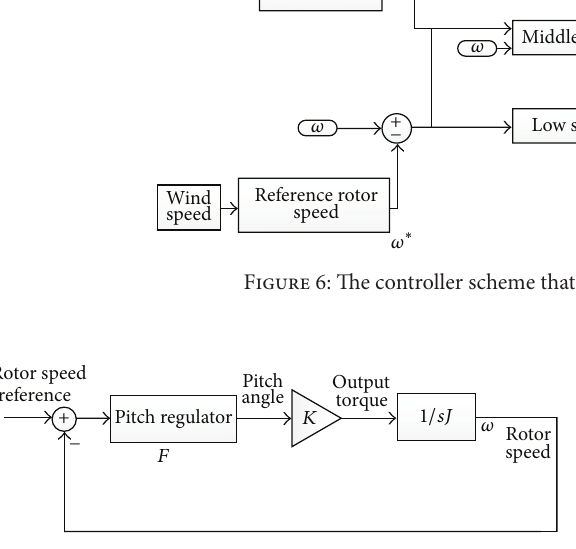
Figure 7: The general scheme of the pitch regulated wind turbine system.